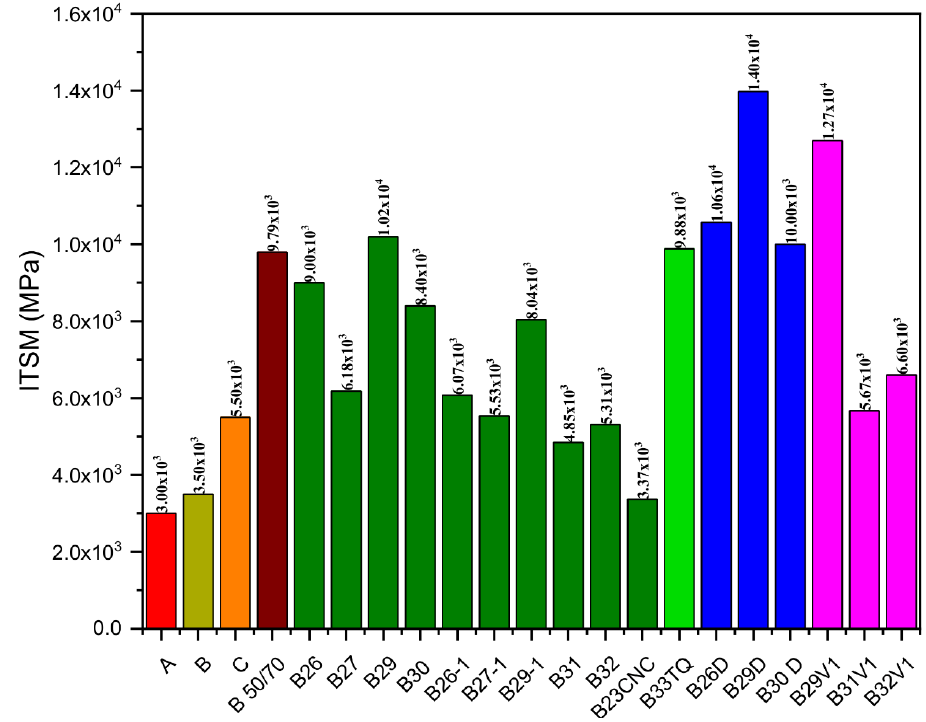
Figure 5. Results of the ITSM values at 20 °C for the recycled asphalt mixtures produced with 100% RAP and the alternative binders. Legend: Asphalt concrete with virgin bitumen and aggregates (A); Asphalt concrete with virgin polymer- modified bitumen and aggregates (B); Reference mix (C);